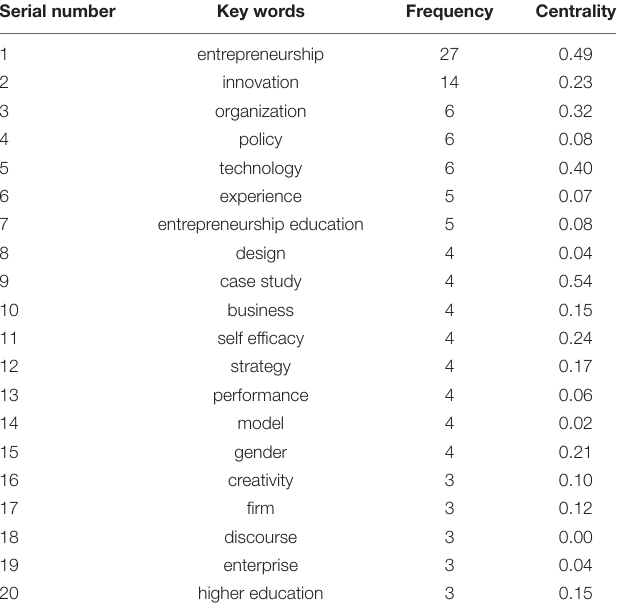
TABLE 1 | Keyword frequency and centrality statistics (top 20) (Retrieved, screenshots and sorted by our research team). Serial